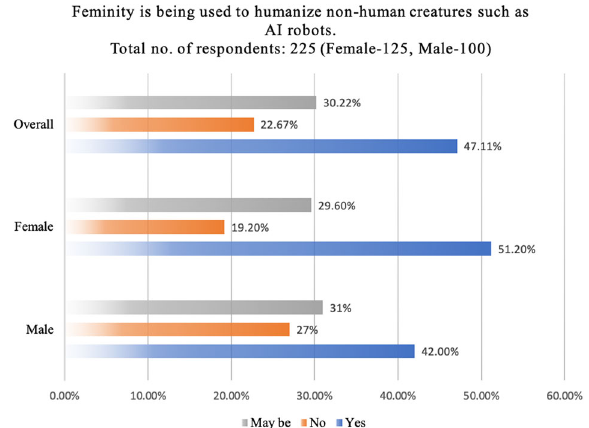
Fig. 12 Female AI robots are more humane than Male robots. Total no. of respondents: 225 (Female: 125, Male: 100).